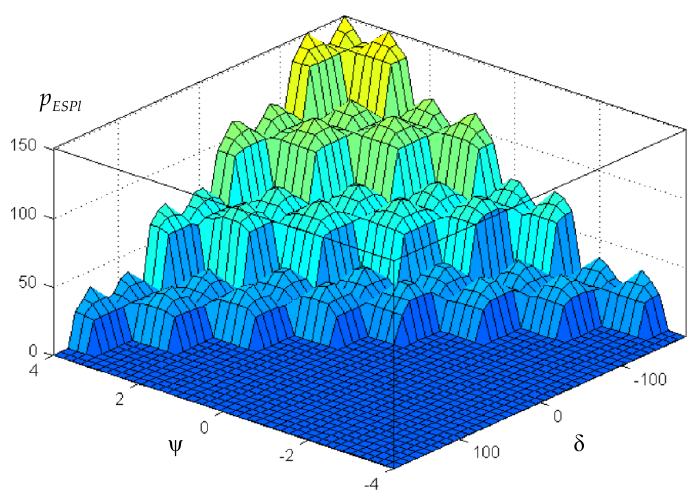
Appl. Sci. 2016 , 6 , 382